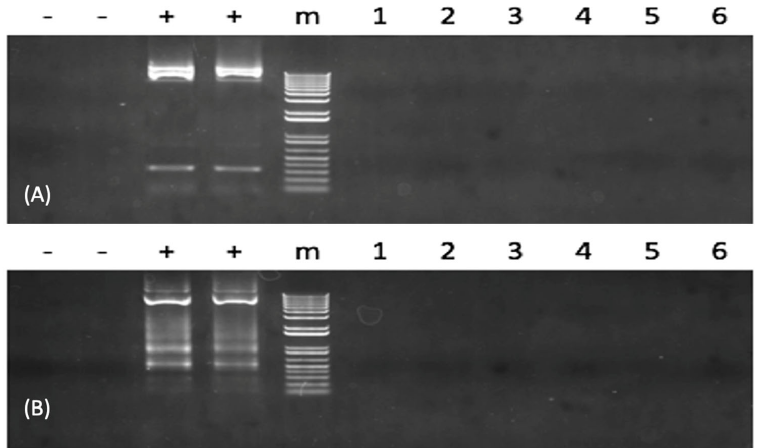
Figure 3. Analysis of transcription activator-like effector nuclease (TALEN) plasmid integration into the genome of channel catfish ( Ictalurus punctatus ) using polymerase chain reaction (PCR) genome. In ( A , B ), from the left to the right lanes of “-” denote the negative controls. The left one indicates using water as a template, and the right one indicates the wild-type channel fish sample; the two “+” denote the positives. The left one indicates the TALEN plasmids containing the left DNA binding site, and the right one indicates TALEN plasmids containing the right DNA binding site; “m” indicates 1 kb molecular weight standard. The same six fsh ‐ mutated channel catfish individuals (numbered 1–6) were checked for plasmid DNA element integration. The cytomegalovirus (CMV) promoter region was resolved in ( A ). The transcription activator ‐ like (TAL) repeats region was resolved in ( B ). The original full gel image of Figure 3 can be found in Supplementary Figure S3.